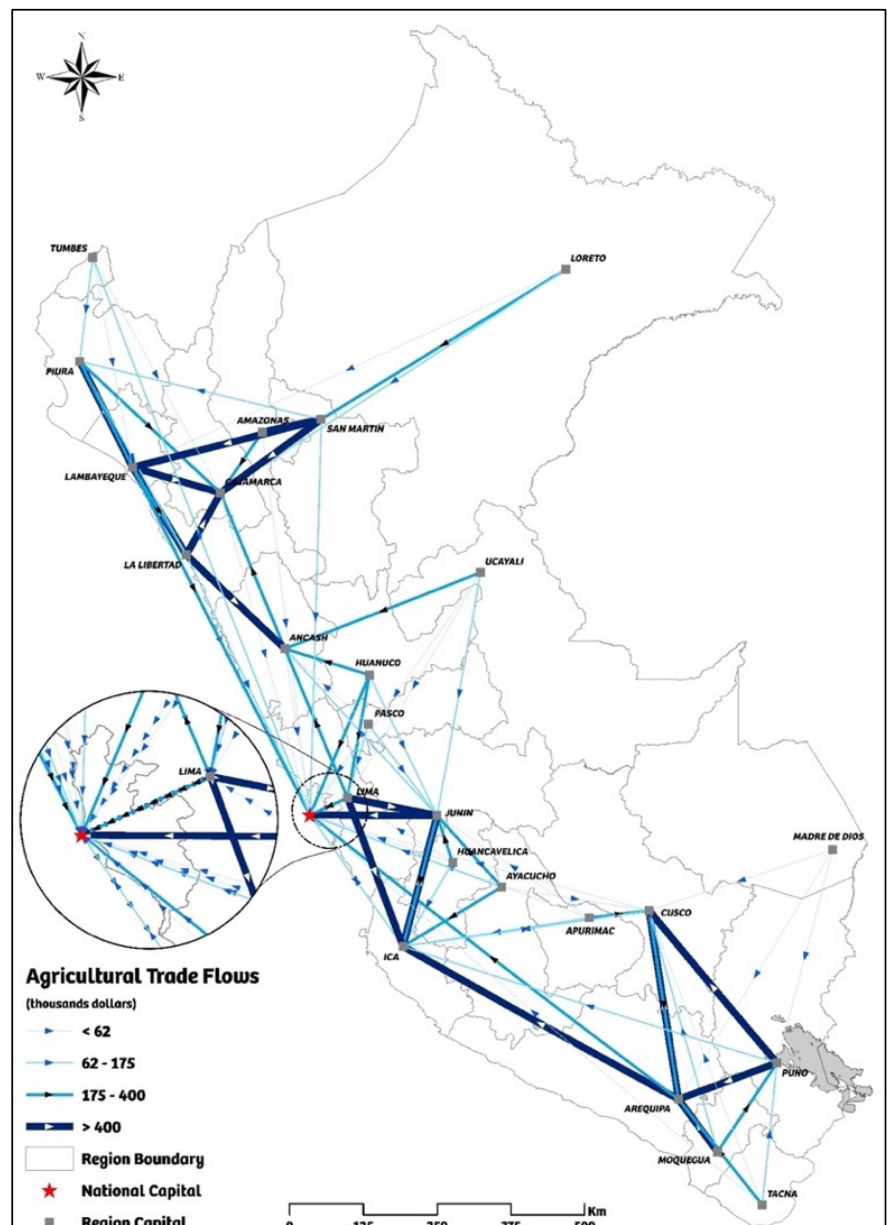
Figure 1. Peru: agricultural trade flows in 2013.